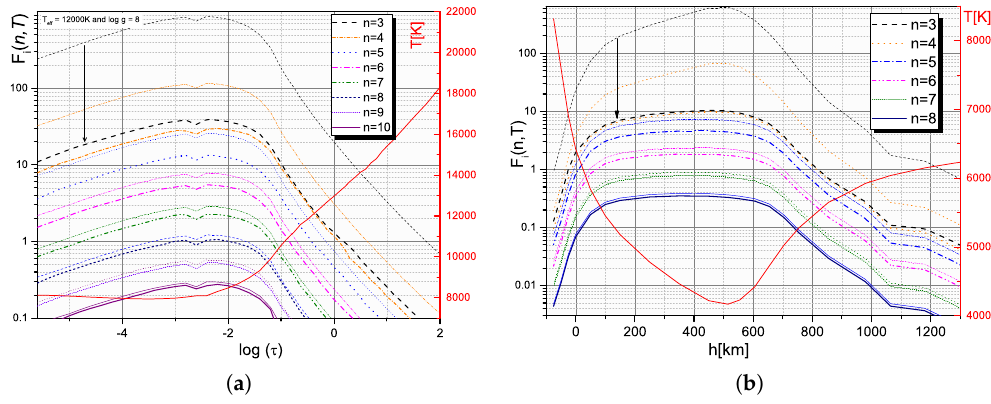
Figure 10. ( a ) parameter F i ( n , T ; He ∗ ( n )) (ratio of fluxes generated in atom–Rydberg–atom and electron-excited atom impact ionization) as a function of the logarithm of Rosseland optical depth log ( τ ) , for principal quantum numbers n = 3–10, with T ef f = 12,000 K and log g = 8: wide line—present calculation; tiny line—calculation from [35]; ( b ) parameter F i ( n , T ; H ∗ ( n )) as a function of the height h, for principal quantum numbers n = 3–8, for model of solar photosphere [39]: wide line—present calculation; tiny line—calculation from